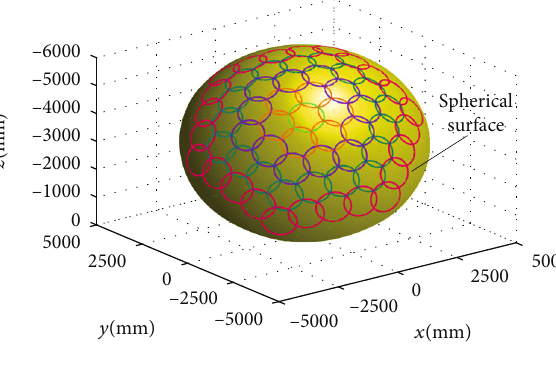
Figure 14: Envelope circle